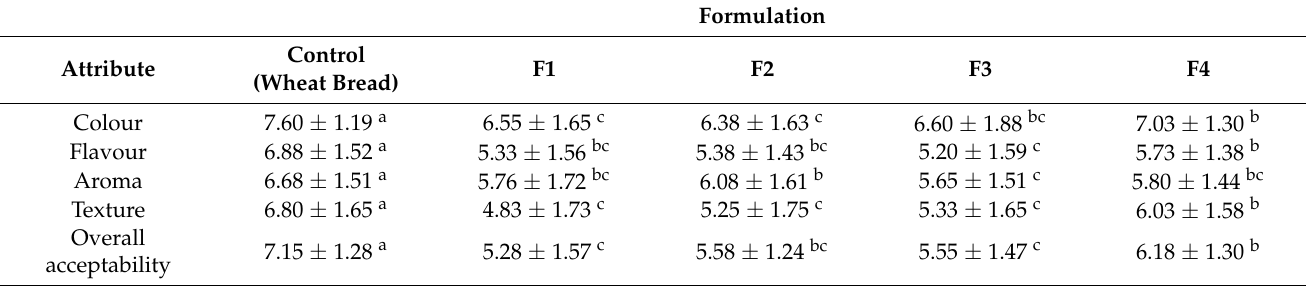
Table 6. Scores for sensory evaluation of control (wheat bread) and gluten-free bread made from